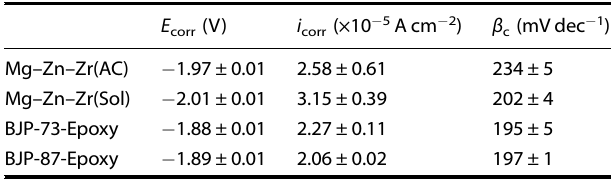
Table 2. Measured electrochemical data of